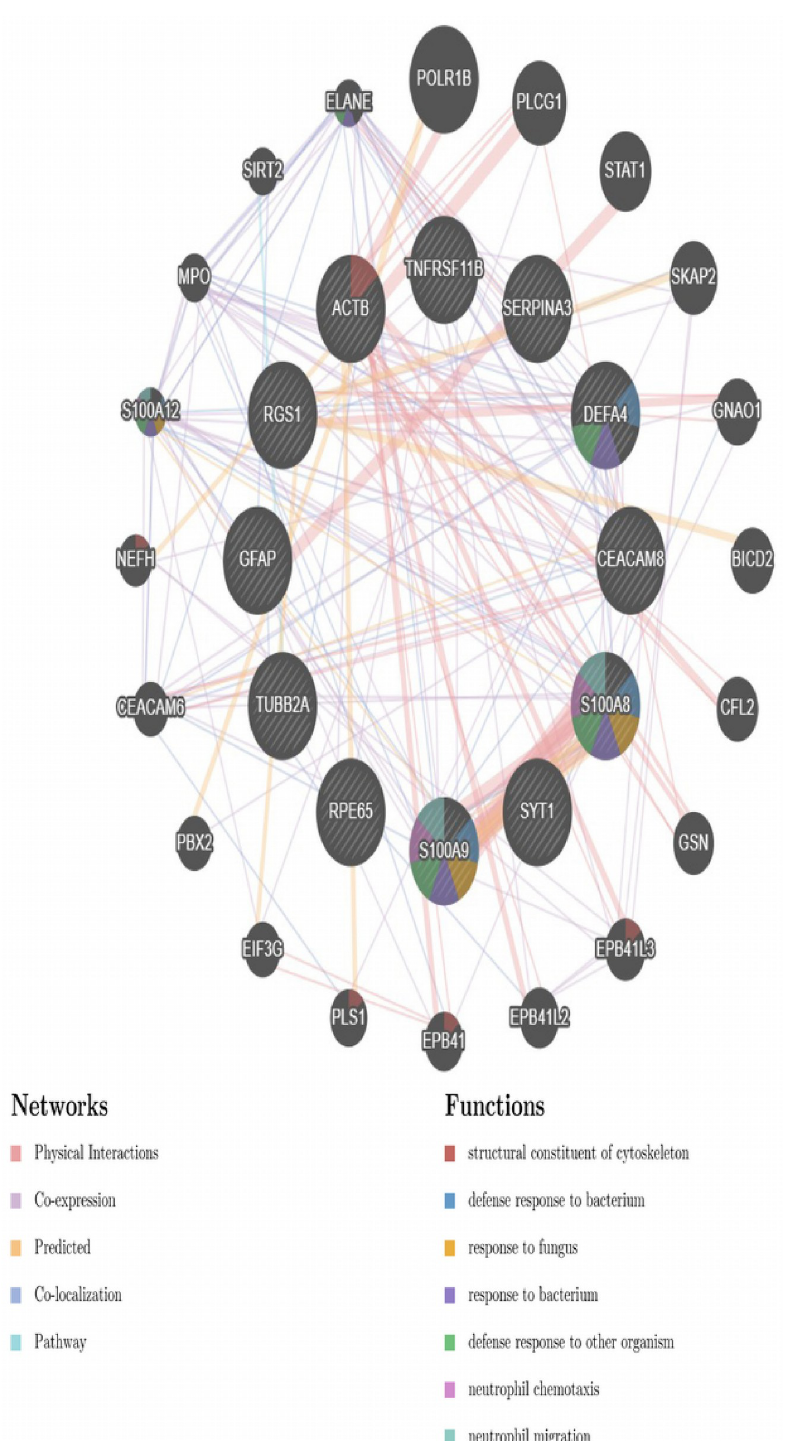
Fig 3. Cluster network with overlapping DEGs between AD and other selected pathologies obtained using the online tool GeneMania [74]. Nodes indicate DEGs and links represent functional associations. The node size indicates the rank of the gene considering its association with other nodes and width of the edges represent the percentile contribution of the connecting nodes to a particular functional association.